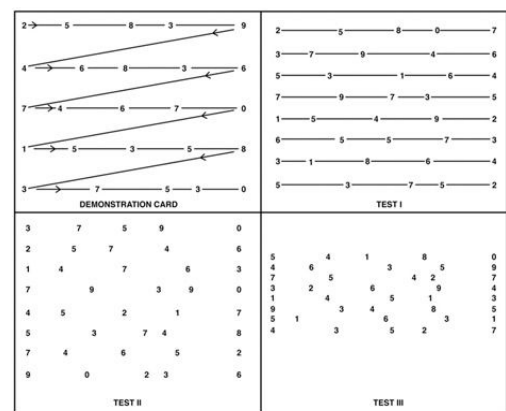
Video See-Through Display